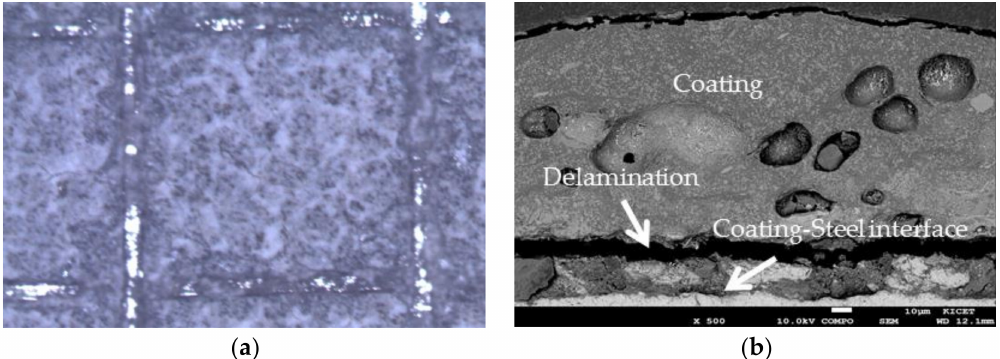
Figure 6. ( a ) Optical microscope image after cross-cut tape test; ( b ) Cross-sectional SEM image after pull-off